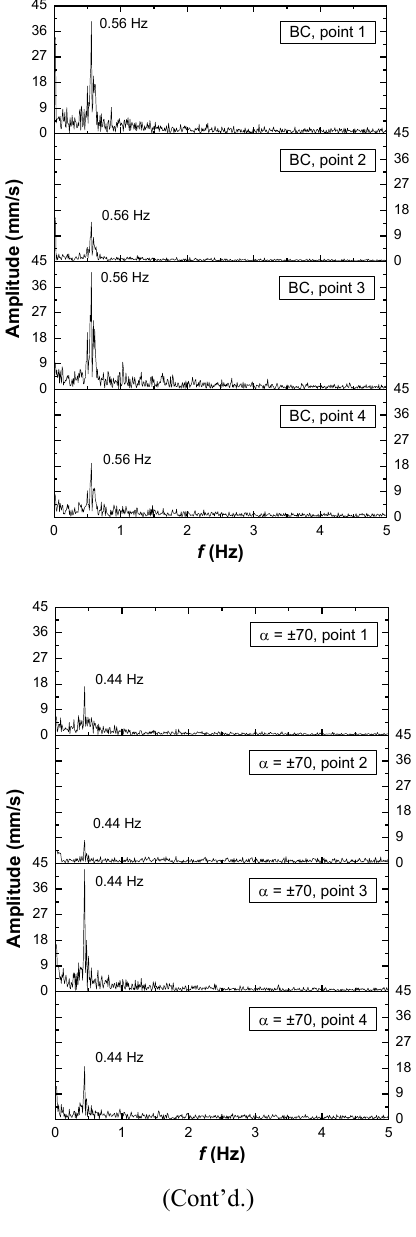
Fig. 8. The location and number of virtual transverse velocity probes behind the cylinder with and without the plates.